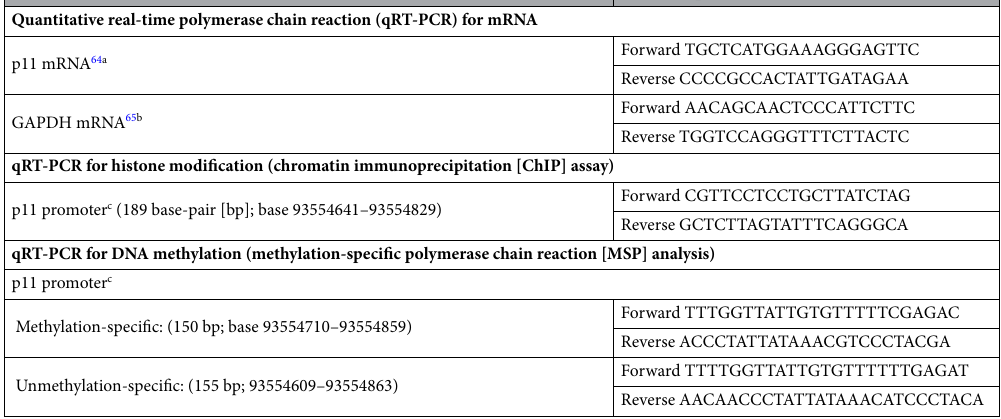
Table 2. Primers used in the study. a Mus musculus S100 calcium binding protein A10 (calpactin; S100a10), mRNA; NCBI Reference Sequence: NM_009112.2. b Mus musculus glyceraldehyde-3-phosphate dehydrogenase (GAPDH), pesudogene 14 (Gapdh-ps14) on chromosome 8; NCBI Reference Sequence: NG_007829.2. c Mus musculus strain C57BL/6J chromosome 3, GRCm38.p4 C57BL/6J; NCBI Reference Sequence: NC_000069.6 (GenBank Assembly ID: